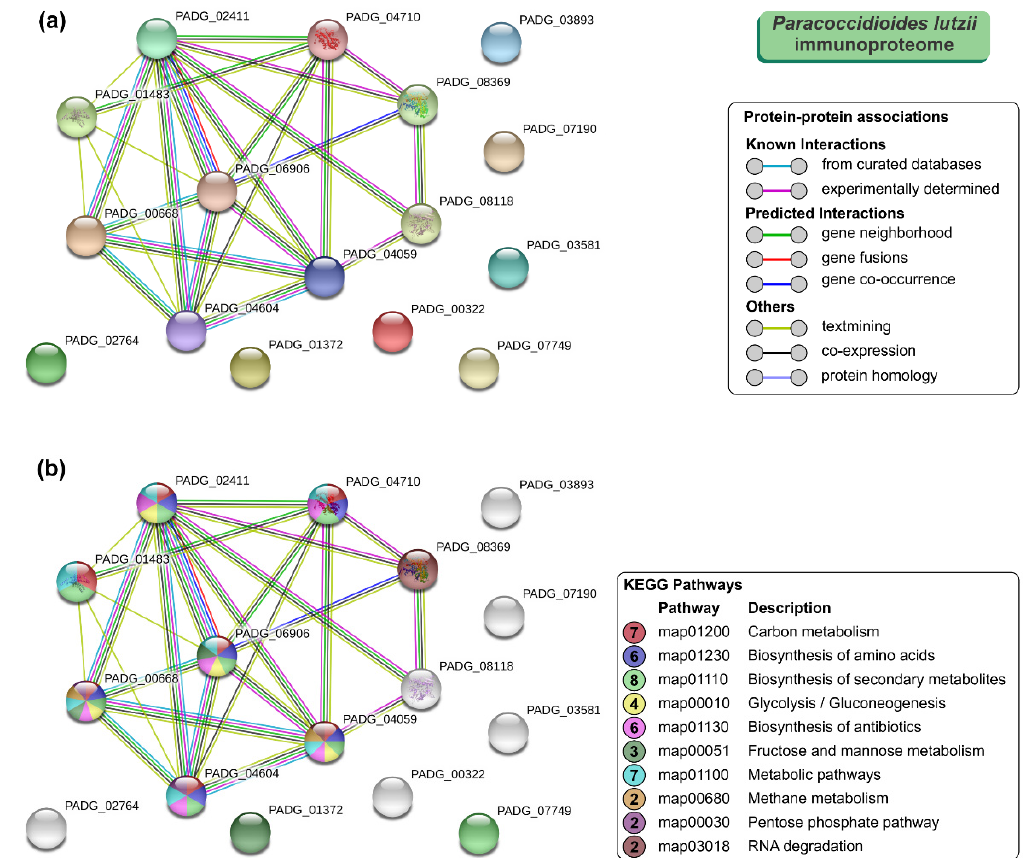
Figure 4. The Search Tool for the Retrieval of Interacting Genes / Proteins (STRING) analysis of Paracoccidioides lutzii immunoproteome. ( a ) A total of 16 immunoreactive proteins from P. lutzii were used as input for STRING analysis, and a network was built based on high confidence evidence from experimental protein–protein interaction (purple line) and curated (light blue lines) databases. Proteins are indicated by nodes labeled with the encoding gene symbol (number of edges = 25) from P. brasiliensis as a model. ( b ) Classification of proteins based on the Kyoto Encyclopedia of Genes and Genomes (KEGG) pathways. Protein–protein interactions’ enrichment p -value = 4.33 × 10 − 15 .